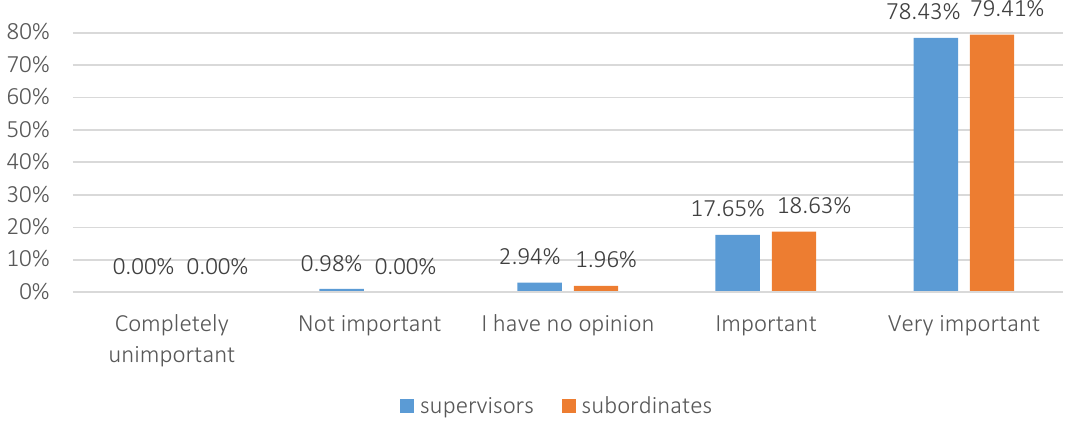
Figure 5. Not reaching for someone else’s property – a summary for the groups of supervisors